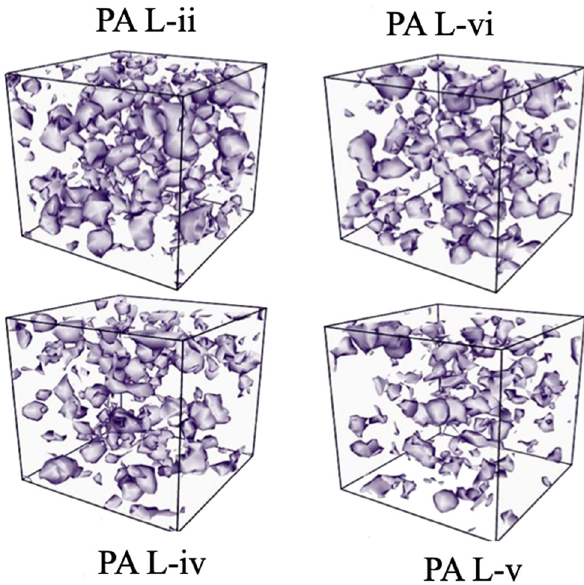
Figure 17: MD simulations of the FV ( void space in gray region ) morphologies of the PAs having pendant trityl group ( 94 ) . Copyright 2017, Reproduced with permission from Elsevier Science Ltd.